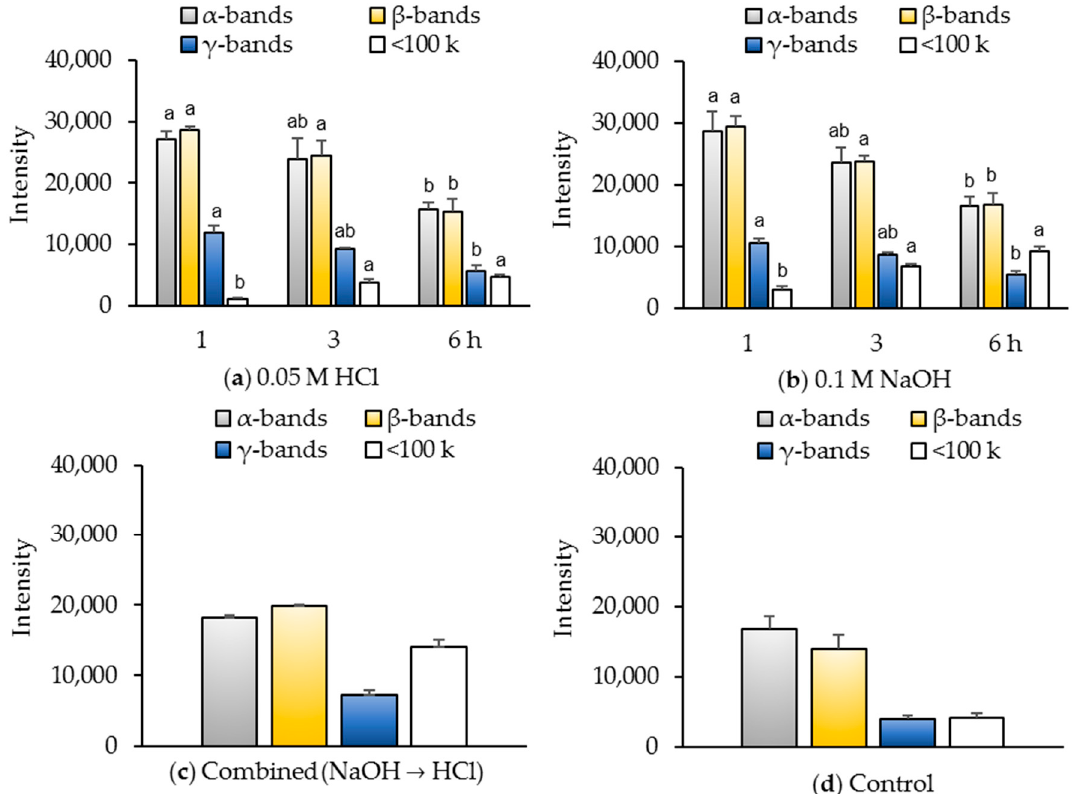
Figure 1. Effects of the pretreatments on the intensities of α -, β -, γ -, and low molecular-weight (<100 k) bands of gelatin in the extracts and the pretreatment solutions in SDS-PAGE (7.5% gel). Gelatins were extracted (65 °C, 1 h, pH 7) from the head skin after being pretreated with ( a ) 0.1 M HCl for 1, 3, and 6 h, ( b ) 0.1 M NaOH for 1, 3, and 6 h, ( c ) the combined pretreatment (NaOH, 1 h → HCl, 1 h), and ( d ) without any pretreatments as the control. Each lane contained 1 µL extract. Columns and bars represent means and standard errors of three replicates, respectively. Different letters in each band indicate a significant difference ( p < 0.05).